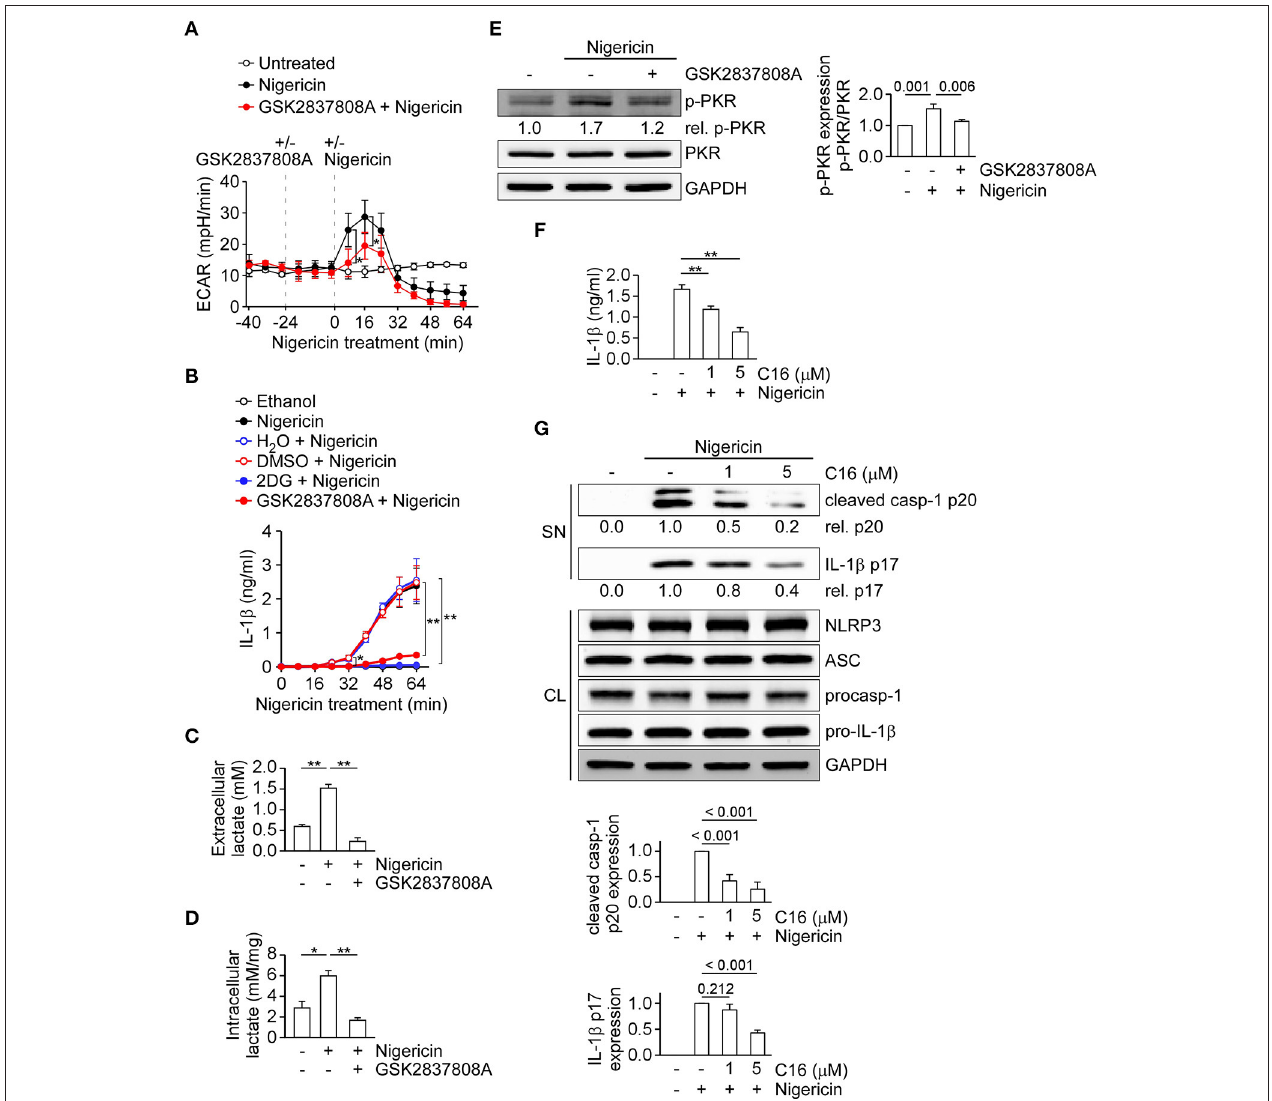
FIGURE 2 | Inhibition of lactate dehydrogenase prevents lactate production and PKR phosphorylation upon NLRP3 inflammasome activation. (A) ECAR of THP-1-derived macrophages under sequential treatment (dotted vertical lines) with or without GSK2837808A and treated with or without nigericin. (B) IL-1 β levels in the culture supernatant of THP-1-derived macrophages that had been pretreated with 2DG or GSK2837808A for 1h, followed by stimulation with nigericin for 0 to 64min. (C) The amount of extracellular lactate in the culture supernatant of THP-1-derived macrophages that had been pretreated with GSK2837808A for 1h, followed by stimulation with nigericin for 45min. (D) Lactate levels in the cell lysates of THP-1-derived macrophages that had been pretreated with GSK2837808A for 1h, followed by stimulation with nigericin for 45min. The lactate levels were calculated by normalization of lactate concentration with the protein levels of cell lysates. (E) Immunoblot analysis of phosphorylated PKR (p-PKR) in THP-1-derived macrophages that had been pretreated with GSK2837808A for 1h, followed by stimulation with nigericin for 45min. The relative amounts of p-PKR were calculated by normalization with total PKR, and the resulting values from the unstimulated control cells were set as 1.0. The densitometric analysis of p-PKR was shown in the right panel. (F) IL-1 β levels in the culture supernatant of THP-1-derived macrophages that had been pretreated with C16 for 1h, followed by stimulation with nigericin for 45min. (G) Immunoblot analysis of NLRP3 inflammasome molecules in culture supernatants (SN) and cell lysates (CL) of THP-1-derived macrophages that had been treated with or without C16 for 1h and then stimulated with nigericin for 45min. The densitometric analysis of caspase-1 (p20) and IL-1 β (p17) was shown in the bottom panel. * P < 0.05; ** P < 0.01. All results are presented as the mean ± SD of the data from three independent experiments ( n = 3 per group), and were analyzed with the ANOVA test followed by post hoc